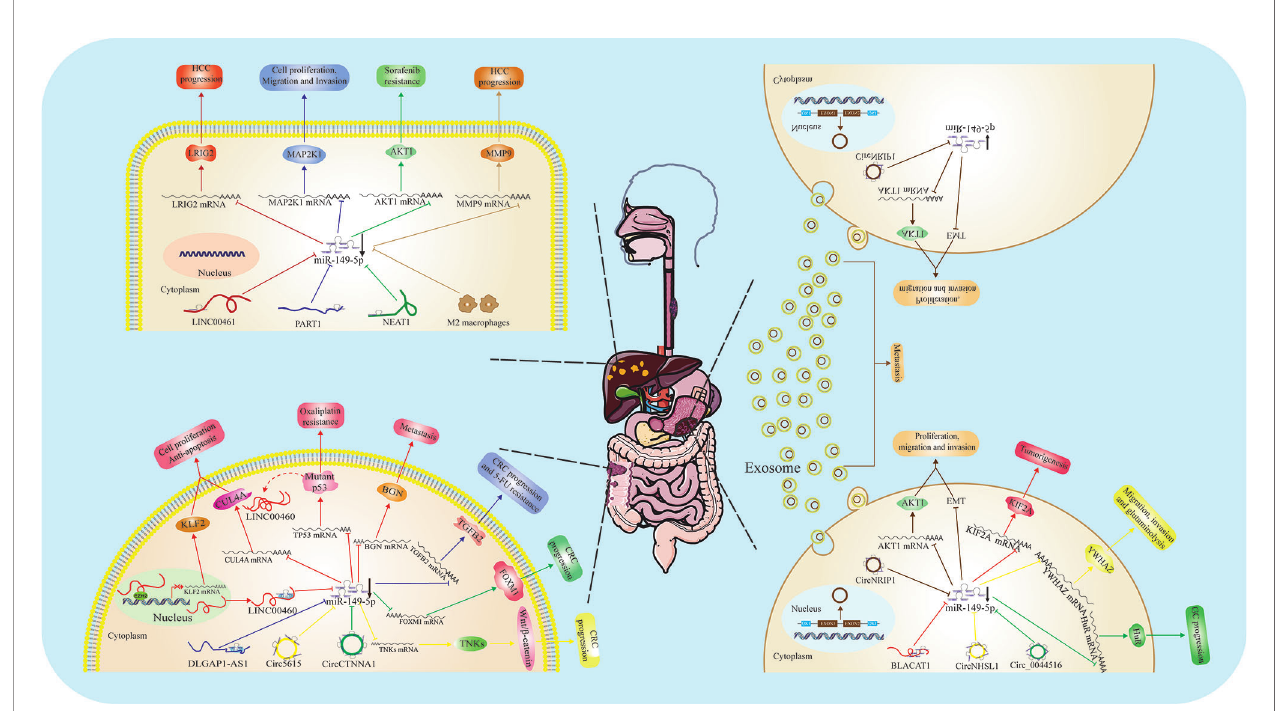
FIGURE 2 | Function and regulatory mechanism of miR-149-5p in digestive system. MiR-149-5p inhibits cell proliferation, migration, invasion and drug resistance in HCC, GC and CRC through binding 3 ’ -UTR of target mRNA. In disease state, miR-149-5p is usually imprisoned by some noncoding RNAs, including LINC00461, PART1, NEAT1 in HCC; LINC00460, DLGAP1-AS1, circ5616 and circCTNNA1 in CRC; BLACAT1, circNRIP1, circNHSL1 and circ_0044516 in GC. In GC, circNRIP1 exists in exosome, and mediates cell to cell